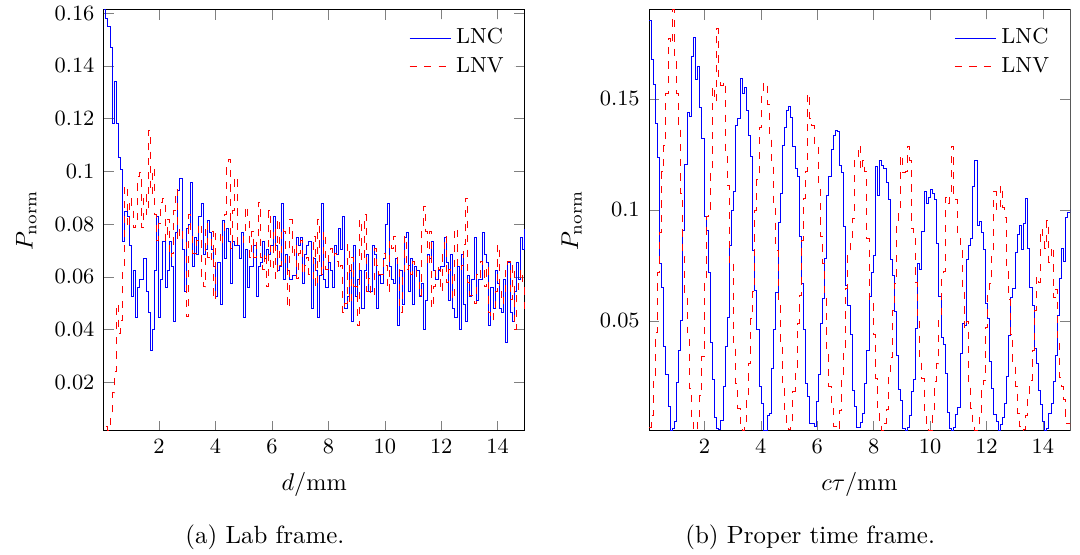
Figure 13 . PDFs of the NN Os in the lab frame are shown in panel (a), and the ones in the proper time frame are shown in panel (b). The parameter point used for these plots features heavy neutrinos with a Majorana mass of m M = 20 GeV , an active-sterile mixing of of ∆ m = 748 (cid:22) eV . The latter corresponds to the linear seesaw BM point with inverted hierarchy. The oscillations are simulated by MadGraph using the model file [ 44 ] presented in section 5 . 1 after applying the patch explained in section 5 . 2 and explicitly given in appendix B. While the oscillations in the lab frame are washed out, they are clearly visible in the proper time